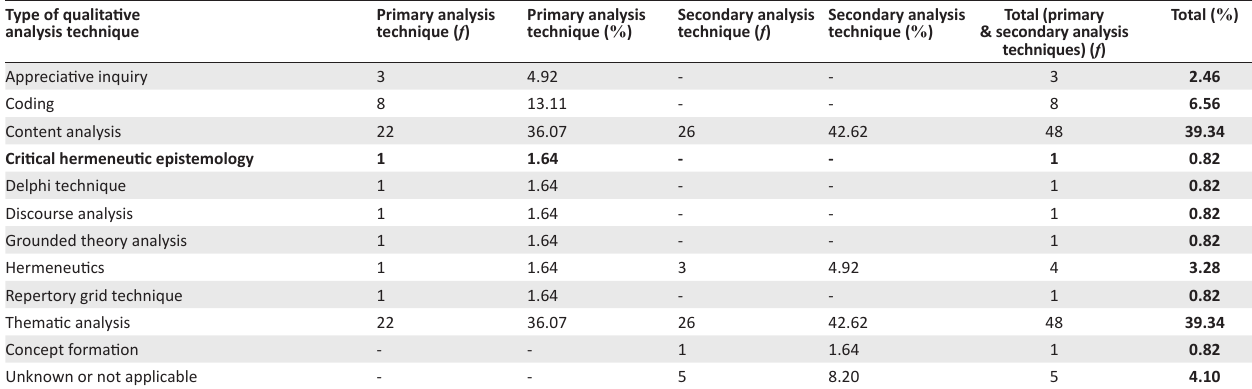
TABLE 8: Qualitative analysis